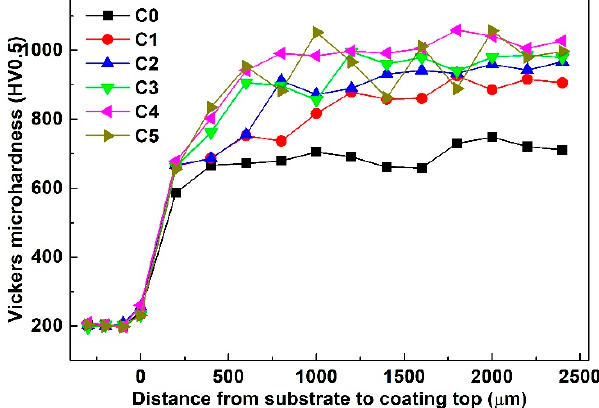
Figure 7. Micro-hardness distribution curves perpendicular to the direction of the fusion line.